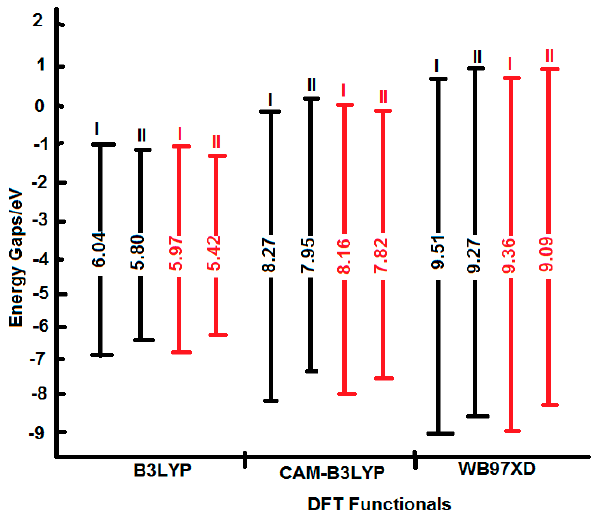
Figure 8. Schematic molecular orbital energy level diagrams of I and II tautomers which have been calculated using B3LYP, CAM-B3LYP, and xB97XD functionals with 6-311++G** (black lines) and aug-cc-pvdz (red lines) basis sets.